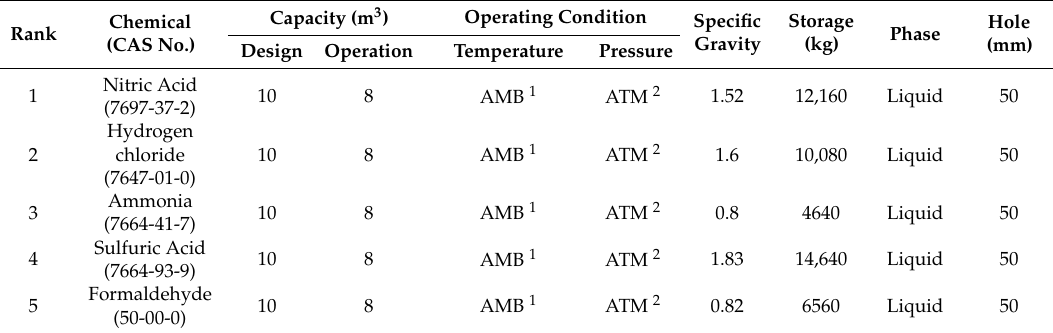
Table 7. Operating and maintaining conditions of storage